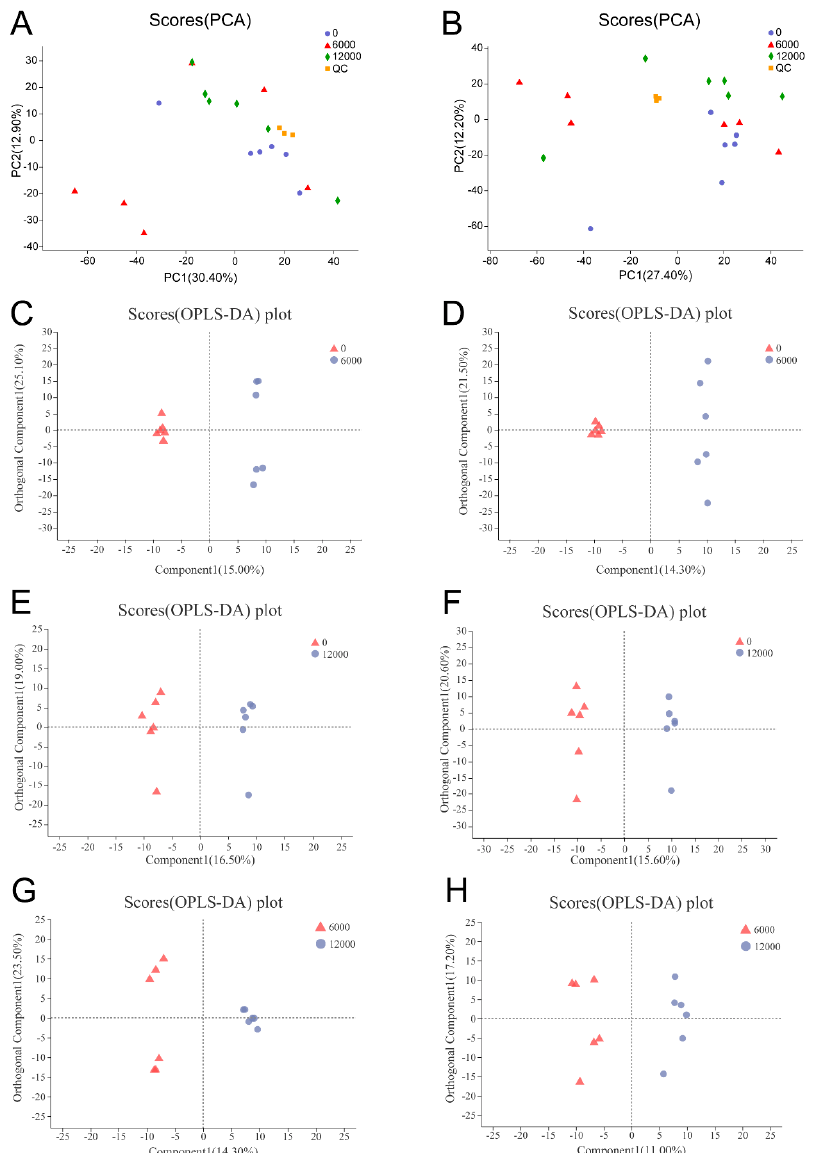
Figure 1. PCA scores plot of L. vannamei given 0, 6000 and 12,000 mg/kg dietary choline chloride: ( A ) ESI + mode; ( B ) ESI − mode. QC is the abbreviation of quality control sample. OPLS-DA scores plot of L. vannamei in the three compared groups: ( C ) ESI + and ( D ) ESI − modes of shrimp given 0 versus 6000 mg/kg choline; ( E ) ESI + and ( F ) ESI − modes of shrimp given 0 versus 12,000 mg/kg choline; ( G ) ESI + and ( H ) ESI − modes of shrimp given 6000 versus 12,000 mg/kg choline.